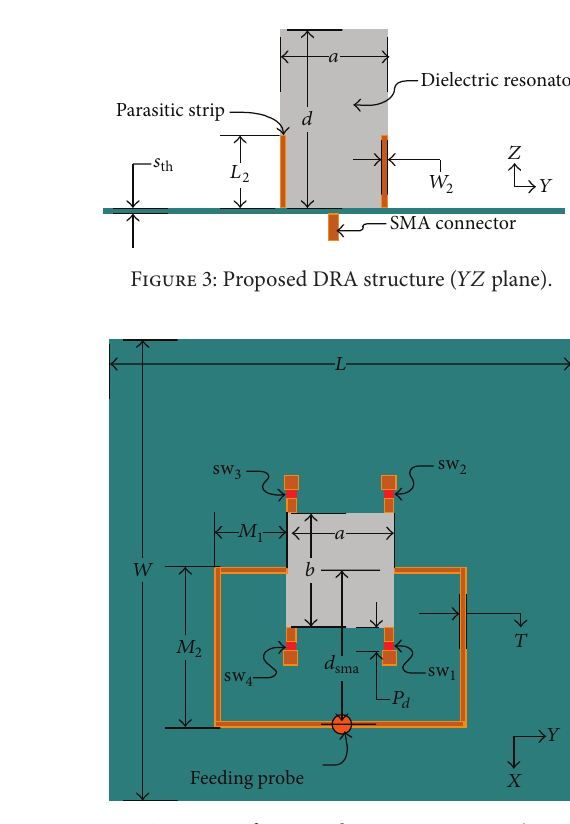
Figure 4: Top view of proposed antenna geometry ( 𝑋𝑌